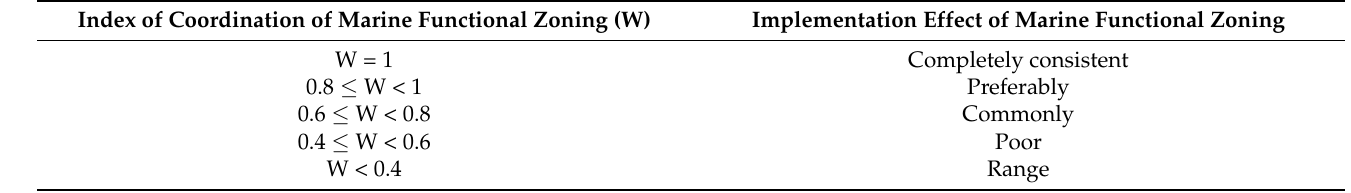
Figure 2. An example of implementation evaluation of marine functional zoning based on planning blueprints. Table 2. Evaluation criteria for the implementation effect of marine functional